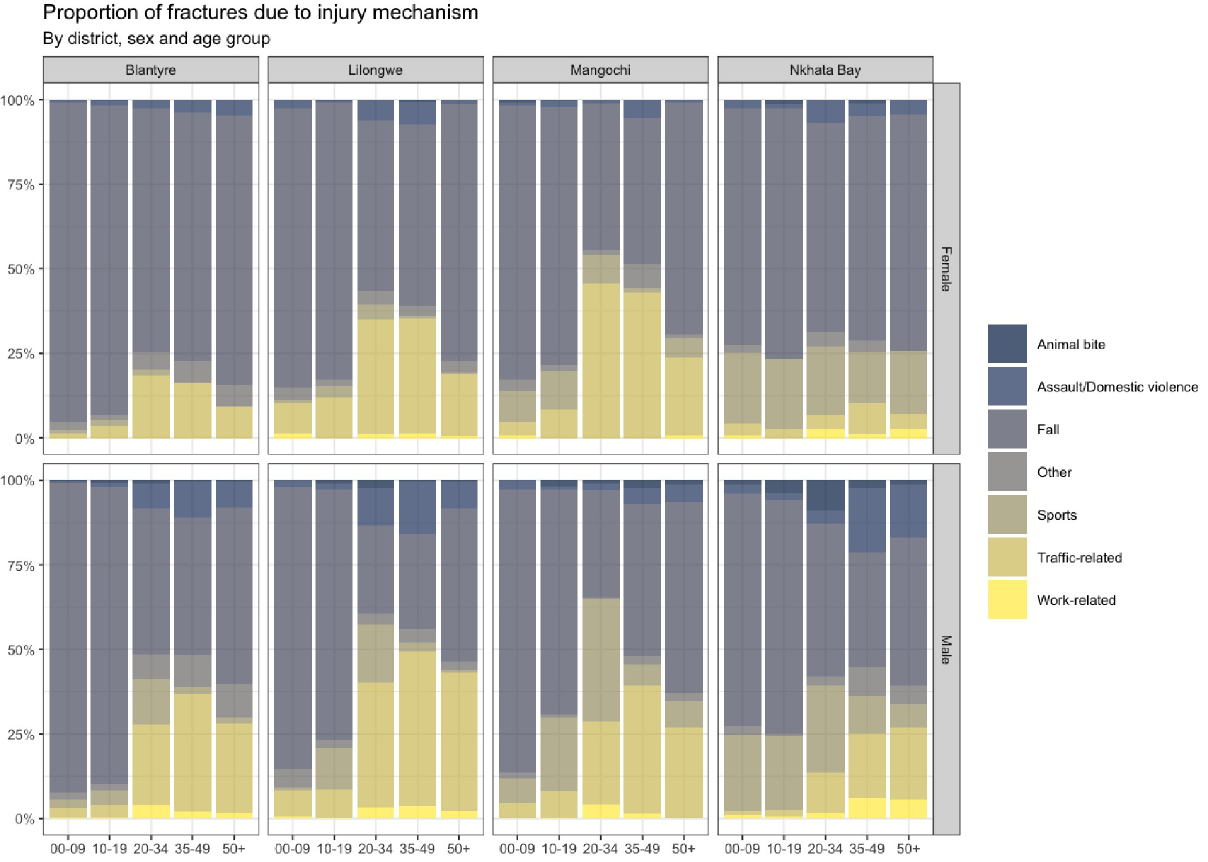
Fig 1. Mechanism of injury according to hospital, gender and age